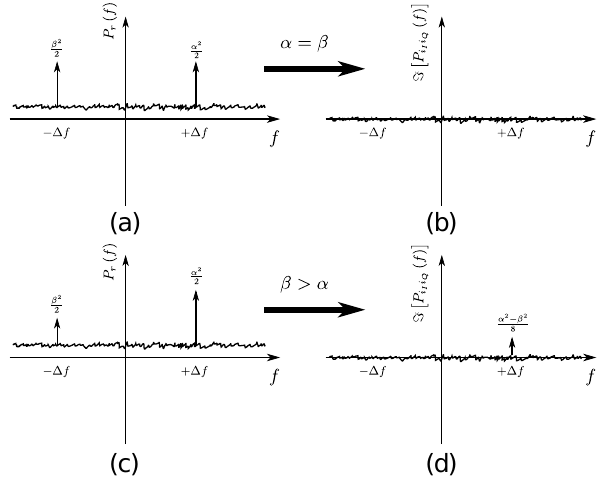
Figure 3. Cross-spectral approach in the event of spectral compo- nents appearing on both sides of zero frequency. Examples of auto- spectra are shown in the left column while the corresponding cross- spectra are shown in the